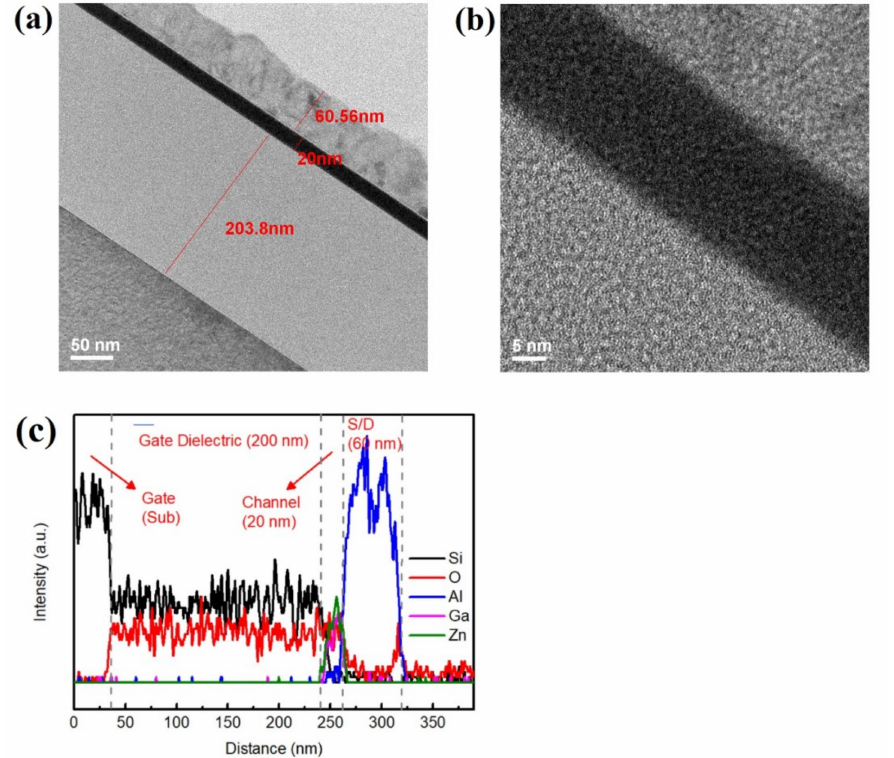
Figure 2. ( a ) Cross-sectional image of photo thin film transistors (PTFT) with Aluminum-Gallium- Zinc oxide (AGZO) power ratio of 60:60 from TEM result; ( b ) HR-TEM image of the AGZO channel layer; ( c ) Line scan profile of thin film transistor (TFT) from TEM